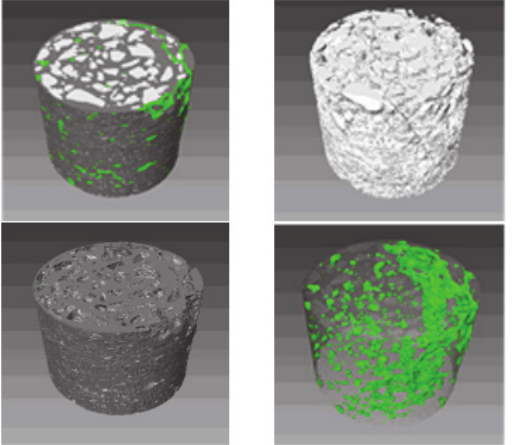
Figure 5: From left to right: test specimens, aggregate, mortar, spatial distribution of cracks.